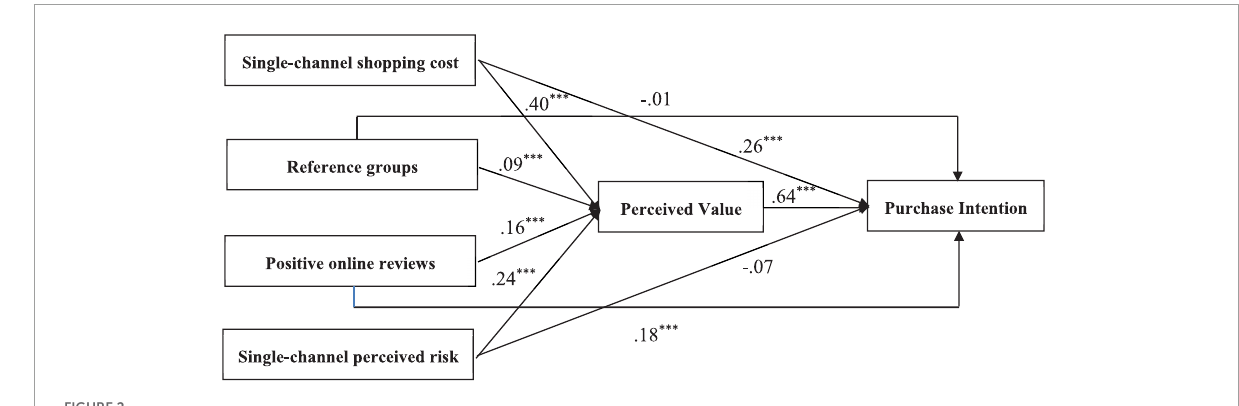
FIGURE2 Path coefficient diagram of structural equation model. *** P < 0.001.